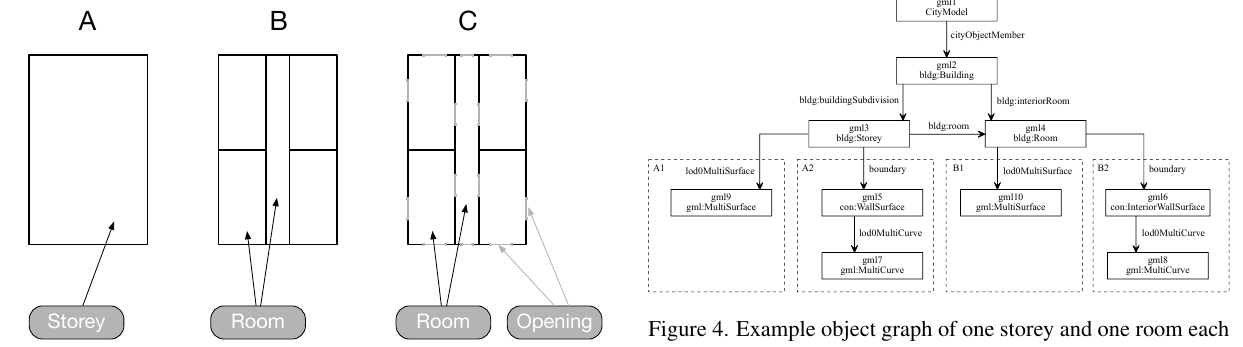
Figure 2. Multiple variants of the realisation of the LoD0 of floor plans. This conceptual illustration does not imply the different ways of the geometric realisation of the features. That is topic is subject of Fig. 3.